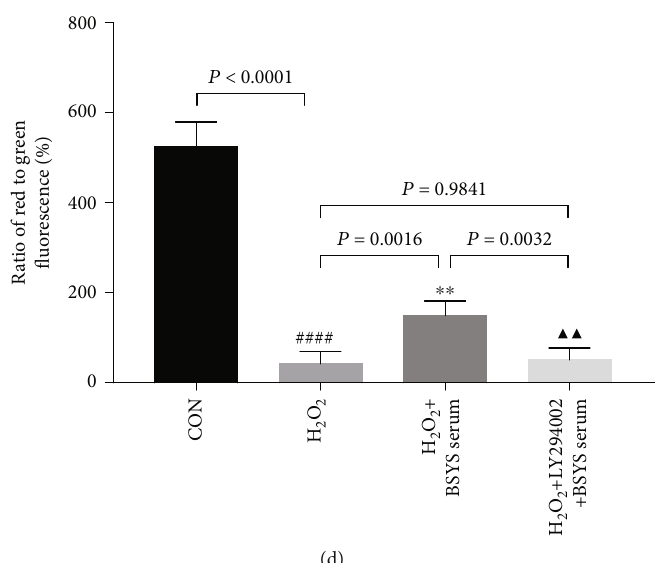
Figure 11: BSYS serum inhibits H O -induced ROS accumulation and MMP decrease via regulating Akt phosphorylation in OLN-93 Cells. 2 2 (a, b) The intracellular ROS level was assessed by DCFH-DA probe using fl uorescence microscope (scale bars: 25 μ m) and microplate reader. (c, d) The MMP was detected via fl uorescence microscope using JC-1 staining. Scale bar = 100 μ m . Data are presented as means ± SD , compared with the CON group, #### P < 0 : 0001 , compared with the H O group, ∗∗ P < 0 : 01 , ∗∗∗ P < 0 : 001 , and compared with the H 2 2 +BSYS serum group, ▲▲ P < 0 : 01 , ▲▲▲ P < 0 : 001